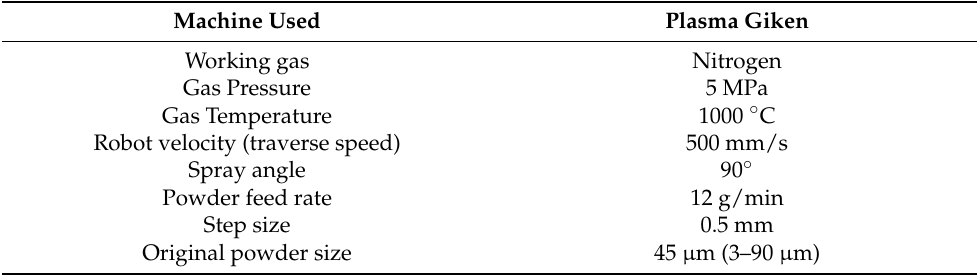
Table 1. Cold spray processing parameters.